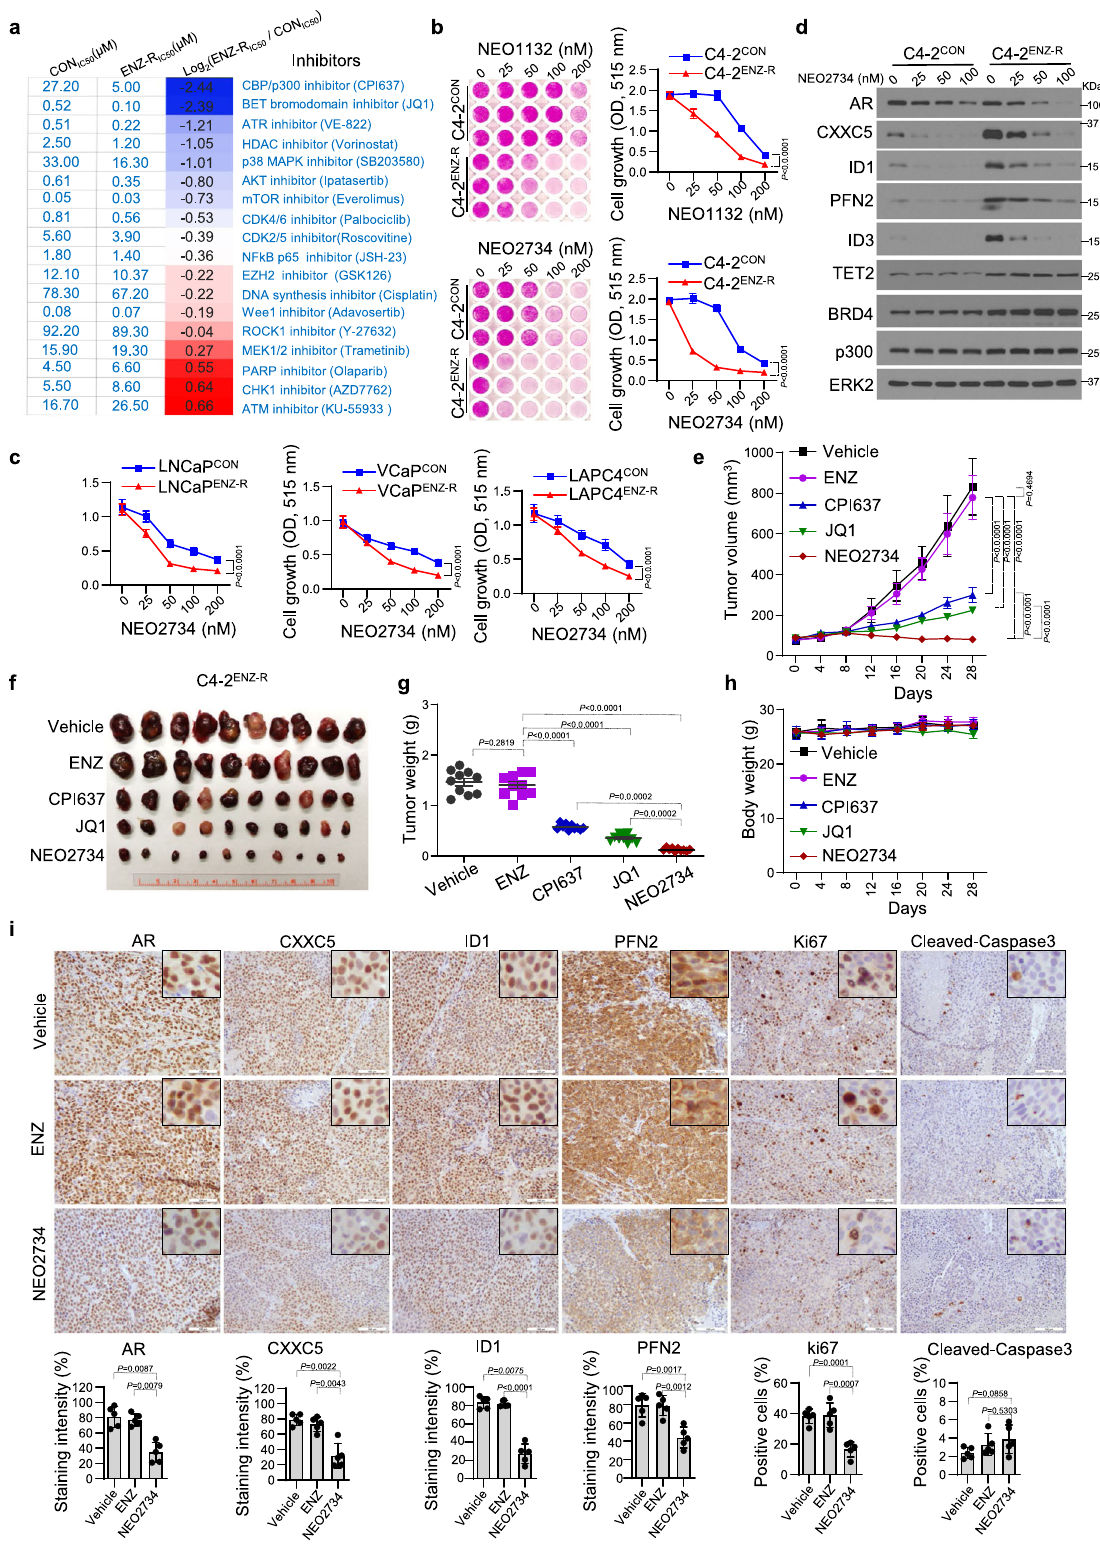
Cell lines and cell culture . LNCaP, VCaP, and LAPC4 PCa cell lines and 293T cell line were purchased from ATCC. C4-2 cells were purchased from Uro Corporation (Oklahoma City, OK). C4-2, LNCaP, VCaP, and LAPC4 cells were maintained at 37°C and 5% CO2 in RPMI 1640 containing 10% fetal bovine serum (FBS) and 1% antibiotic/antimycotic (Thermo Fisher Scienti fi c). 293T cells were maintained in DMEM medium with 10% FBS. To establish ENZ resistant cell lines, C4-2, LNCaP,